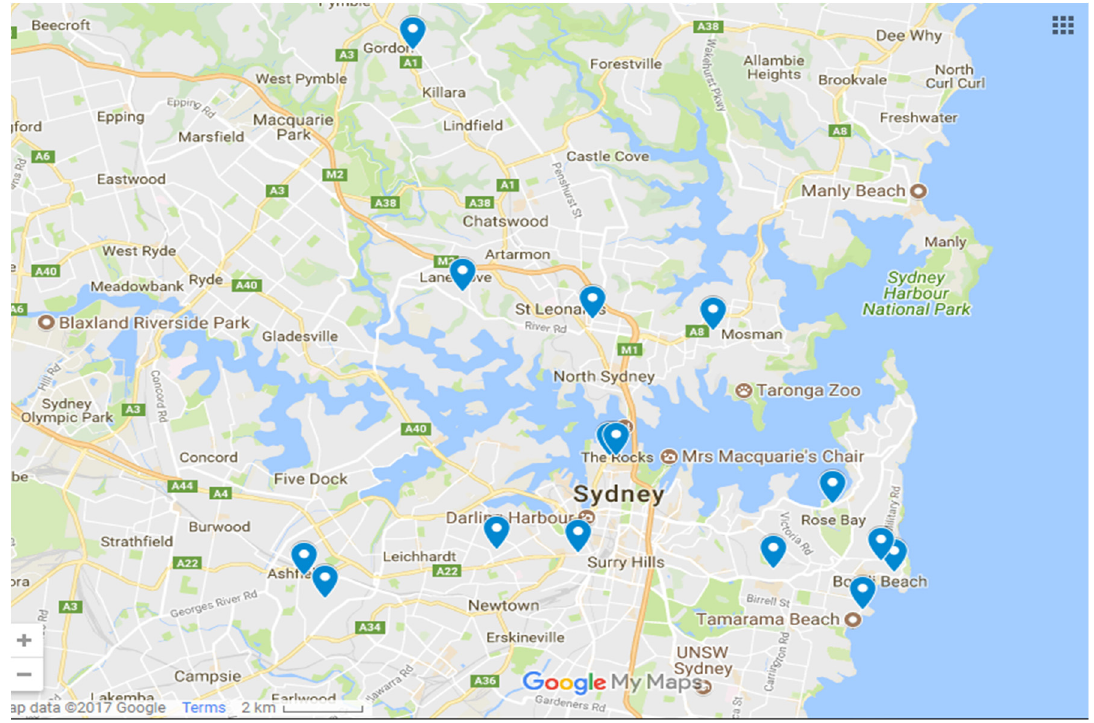
Figure 1. Spatial distribution of the study sites (image: Google maps).